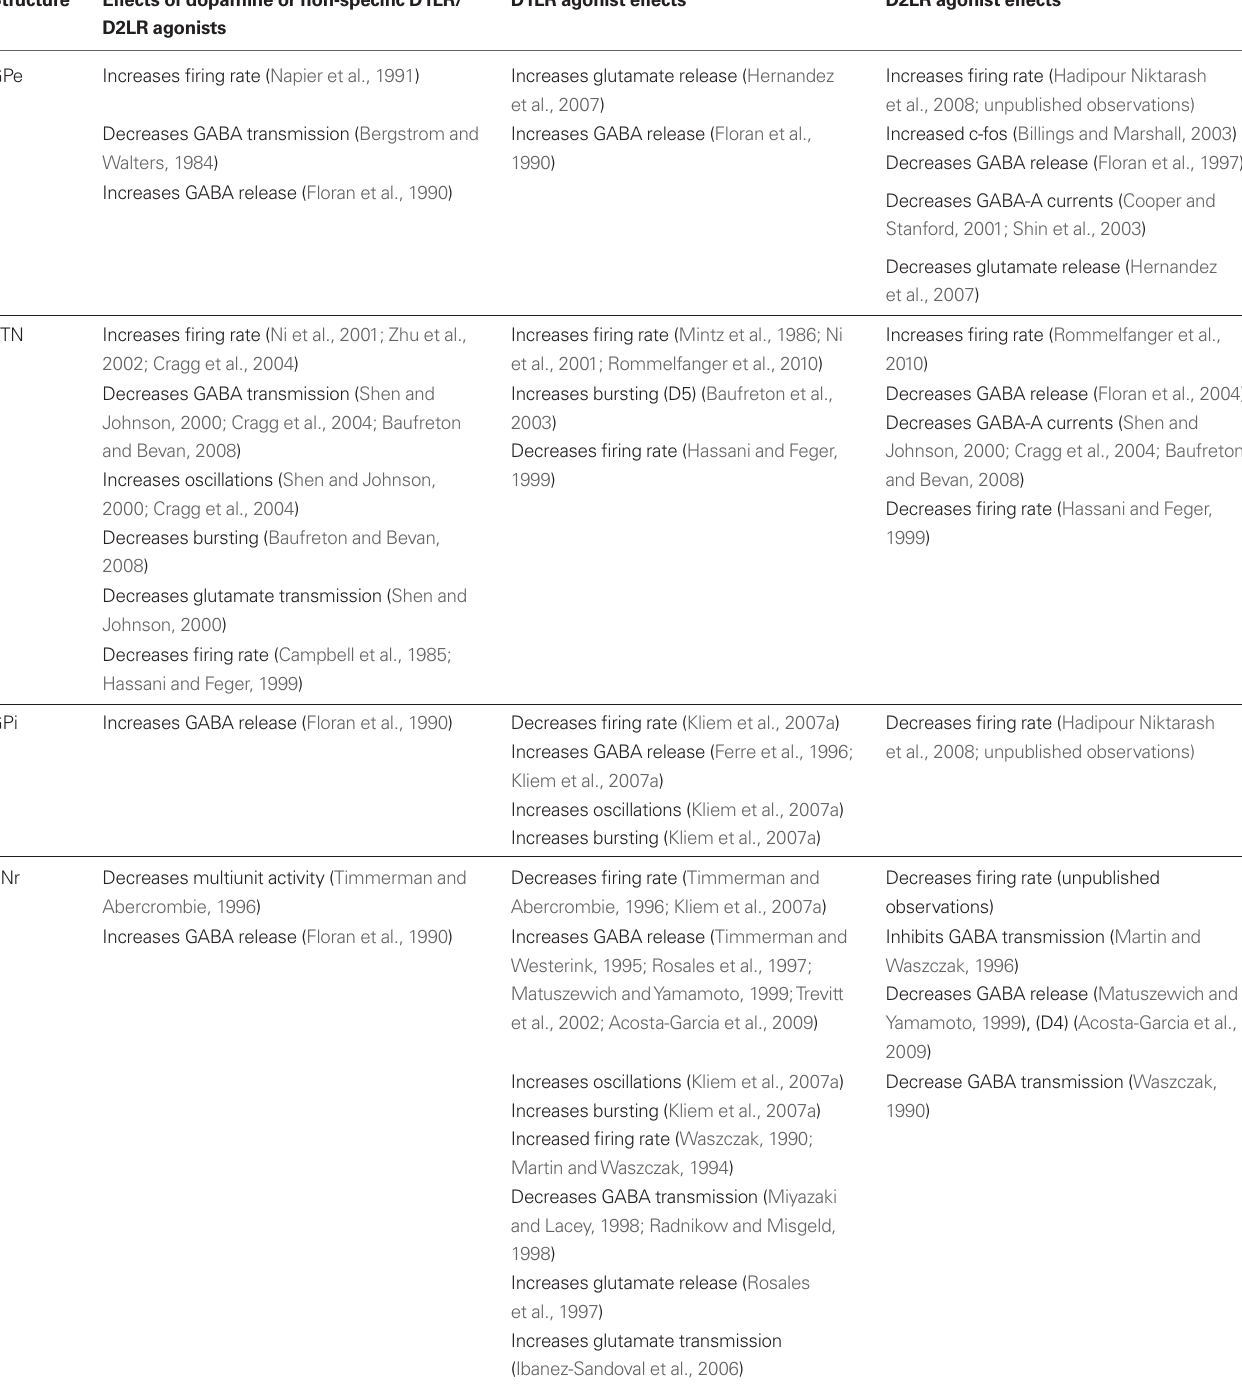
Table 2 | Functional effects of dopamine receptor agonists.